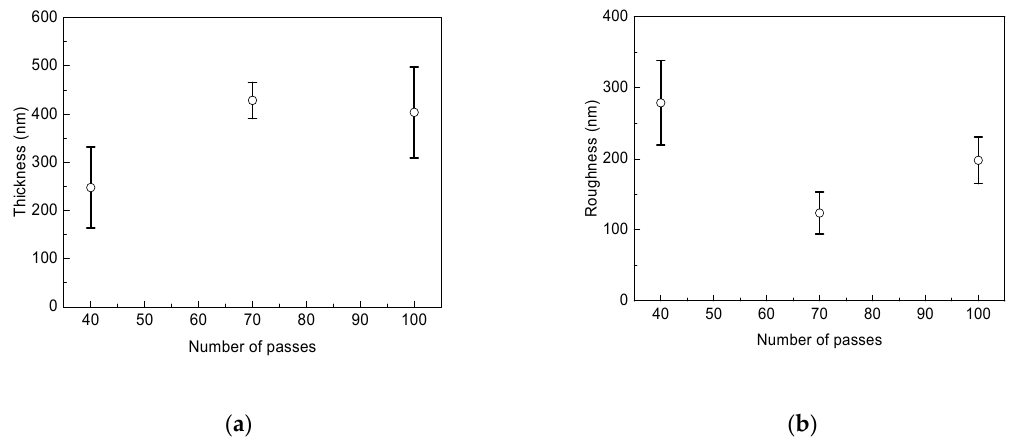
Figure 7. Measured ( a ) thickness and ( b ) roughness of spray-on perovskite films deposited on the substrates kept at the ambient temperature, at various number of spray passes.